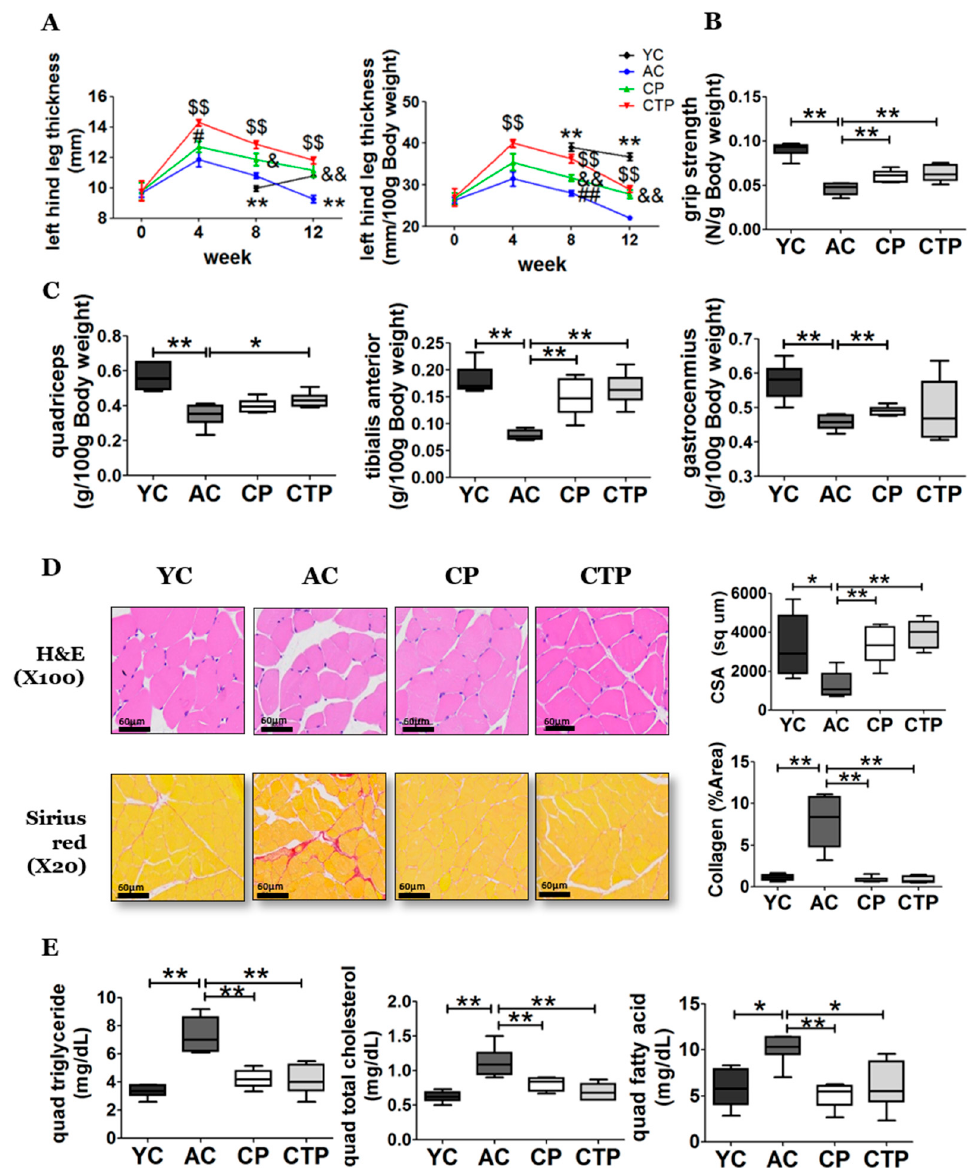
Figure 1. Effect of a 12-week supplementation of CP and CTP on the left-hind-leg thickness, grip strength, muscle weight, and gastrocnemius histopathology. ( A ) Left-hind-leg thickness. The quad- riceps (quad), gastrocnemius, and tibialis anterior were sampled. Data are the mean ± SE. Significant differences between YC versus AC are indicated as follows: * p < 0.05, ** p < 0.01. Significant differ- ences between CP versus AC are indicated as follows: & p < 0.05, and && p < 0.01. Significant differ- ences between CTP versus AC are indicated as follows: $$ p < 0.01. Significant differences between CP versus CTP are indicated as follows: # p < 0.05, ## p < 0.01. ( B ) Grip strength (N/g body weight). ( C ) Muscle tissue weight (g/100g body weight). ( D ) H&E and Sirius red stained transverse-sections of gastrocnemius muscle and fiber cross-sectional area. Scale bar = 60 µm. ( E ) Quadriceps triglycer- ide, quadriceps total cholesterol, and fatty acid. Data are presented as the mean ± SE. Significant differences are indicated as follows: * p < 0.05, and ** p < 0.01. YC, young mice control (12 weeks old, n = 6); AC, aging control (60 weeks old, n = 6); CP, collagen peptide (60 weeks old, n = 6); CTP, collagen tripeptide (60 weeks old, n = 6).